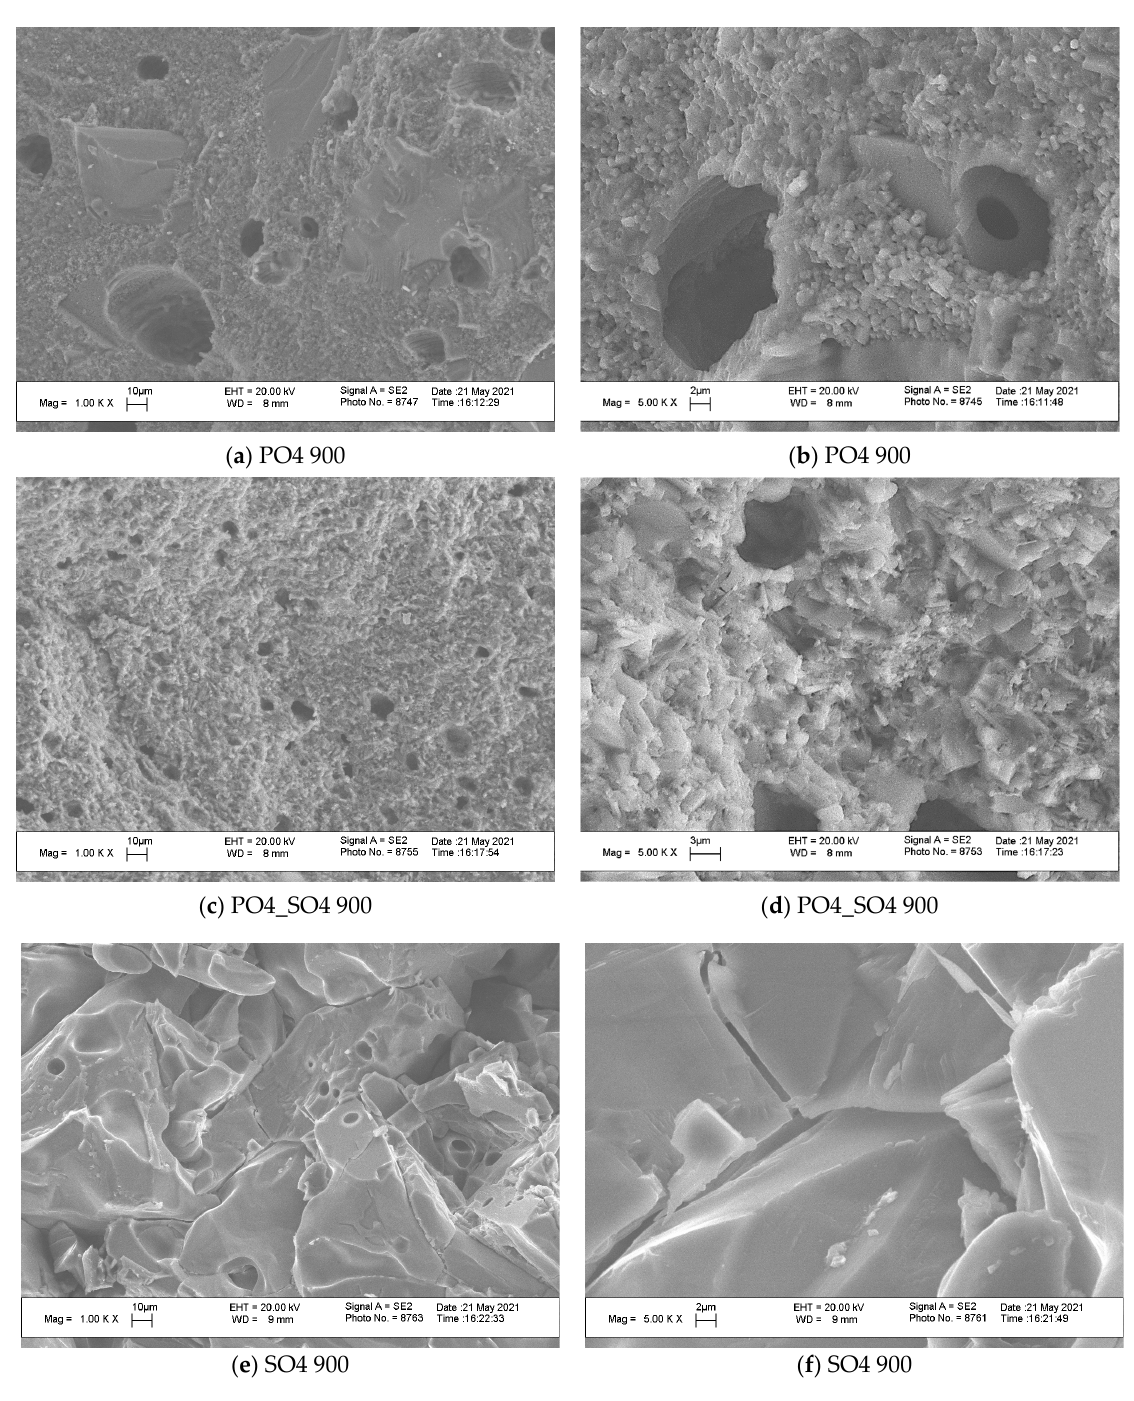
Figure 11. Micrographs of cross-sections of ceramic samples based on powders synthesized from calcium chloride CaCl 2 and sodium hydrophosphate Na 2 HPO 4 solutions ( a , b ); based on calcium chloride CaCl 2 and mixed-anionic (Na 2 HPO 4 /Na 2 SO 4 ) solutions ( c , d ); and based on calcium chloride CaCl 2 and sodium chloride Na 2 SO 4 solutions ( e , f ), after firing at 900 ° С . Figure 12 shows micrographs of the surfaces of ceramic samples based on a powder synthesized from calcium chloride CaCl 2 and a mixed-anionic solution of sodium hydro- gen phosphate and sodium sulfate Na 2 HPO 4 /Na 2 SO 4 after firing at different temperatures in interval 800–1000 °C.